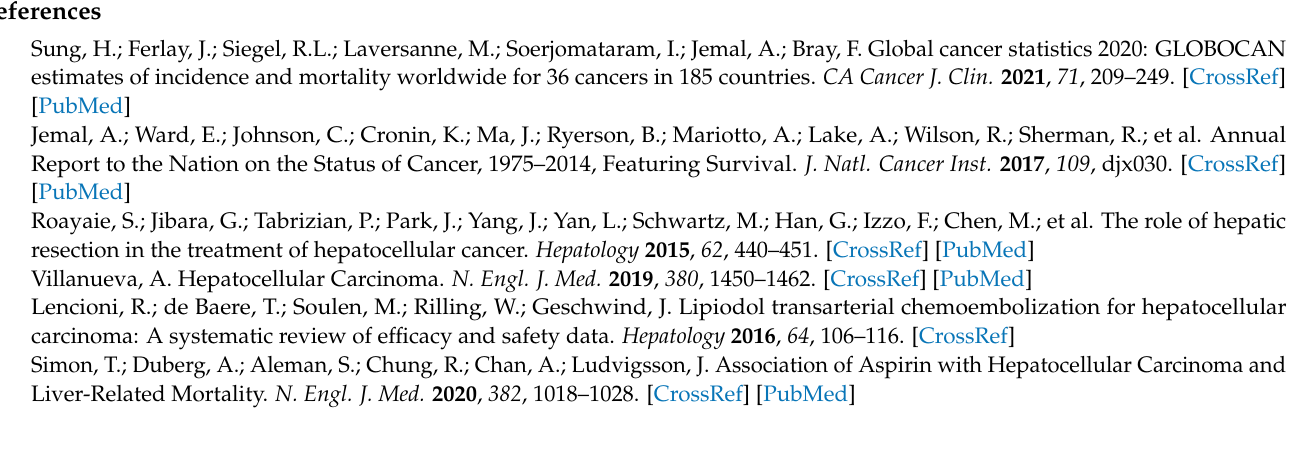
current research; Table S2: Stemness index (mRNAsi) of 1059 HCC patients from five cohorts; Table S3: Thirteen HSRM hub genes selected by LASSO regression models; Table S4: Topoisomerase inhibitors, CDK inhibitors, and HDAC inhibitors predicted to transcriptionally inhibit cancer stemness of